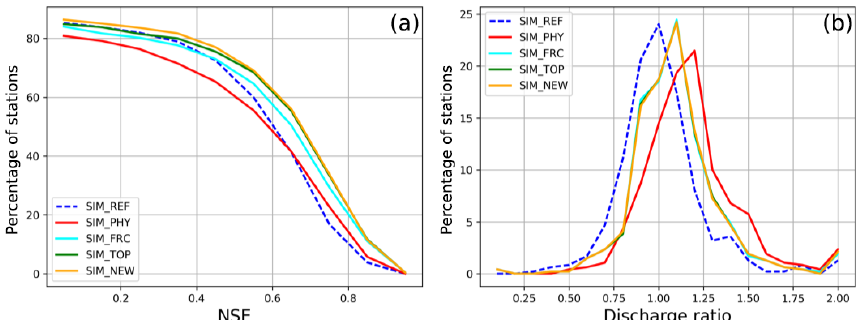
Figure 5. Comparison of the NSE CCDF (a) and the simulated to observed flow ratio (b) for SIM_REF (dashed blue line), SIM_PHY (solid red line), SIM_FRC (solid cyan line), SIM_TOP (solid green line), and SIM_NEW (solid orange line).